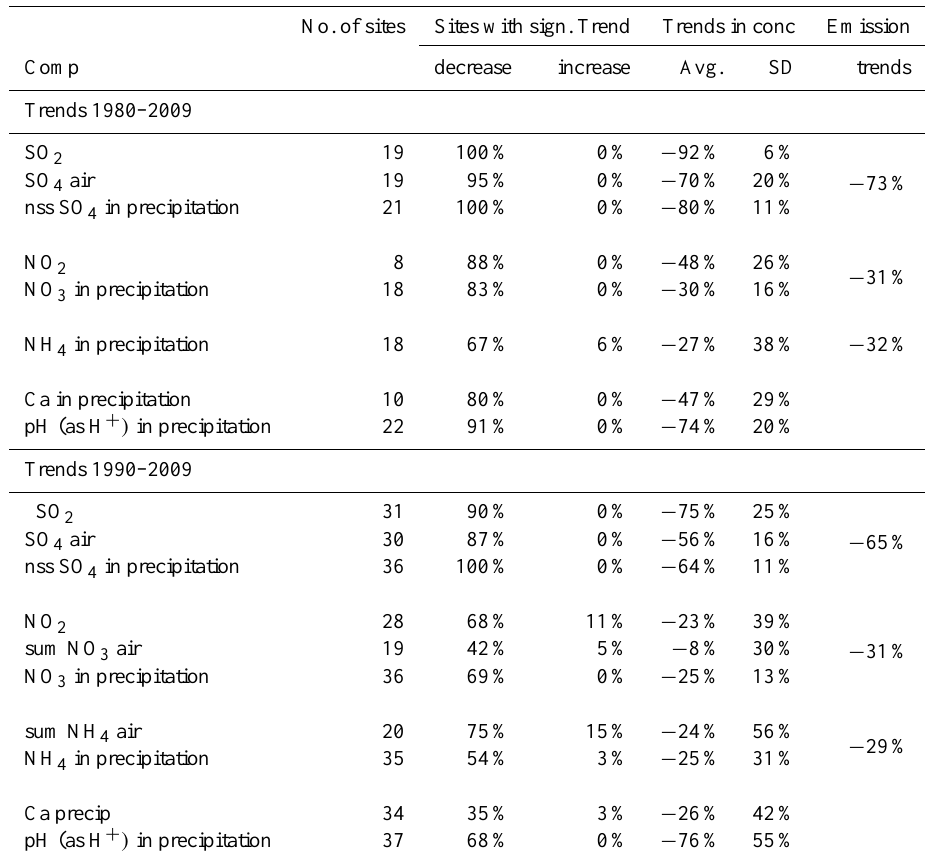
Table 3. Average trends in concentration of major components in air and precipitation and the number of sites with significant trends in accordance to Mann Kendall test for the periods 1980–2009 and 1990–2009 compared to the emission trends in Europe (EMEP/CEIP,